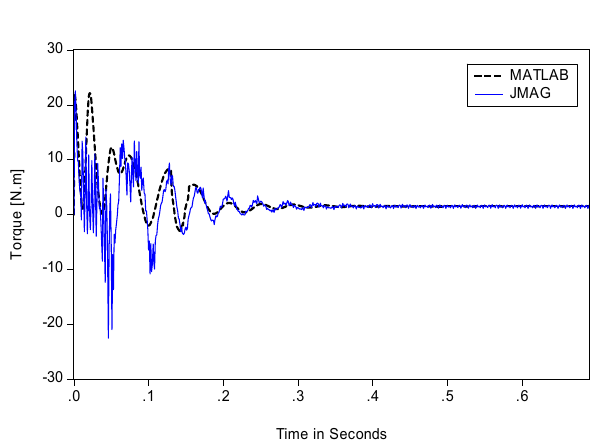
Figure 8. Electromagnetic torque at 1.5 N ∙ m load. Energies 2018 , 11 , 197 12 of 17